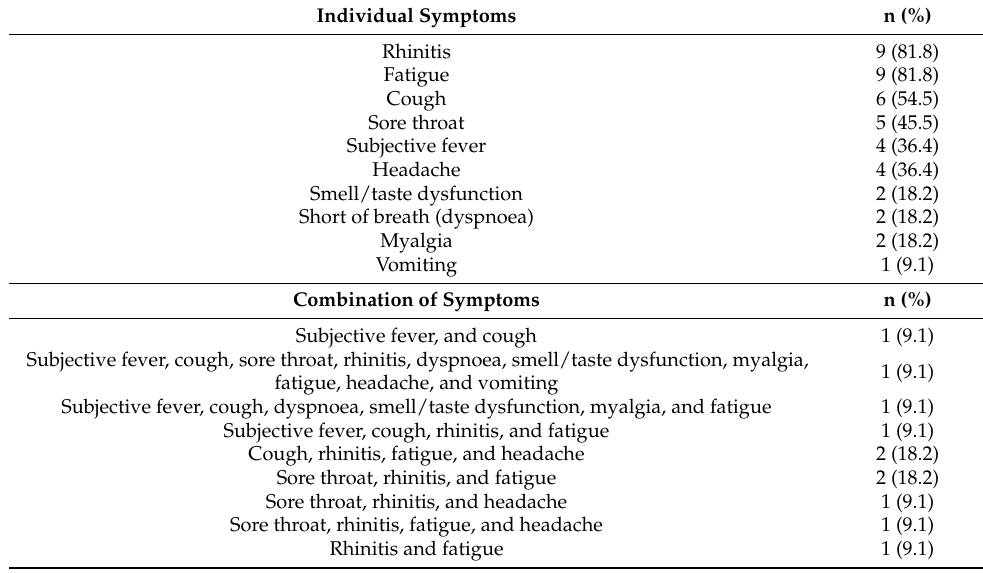
Table 3. Reported symptoms of respiratory tract infections among participants (n = 11).